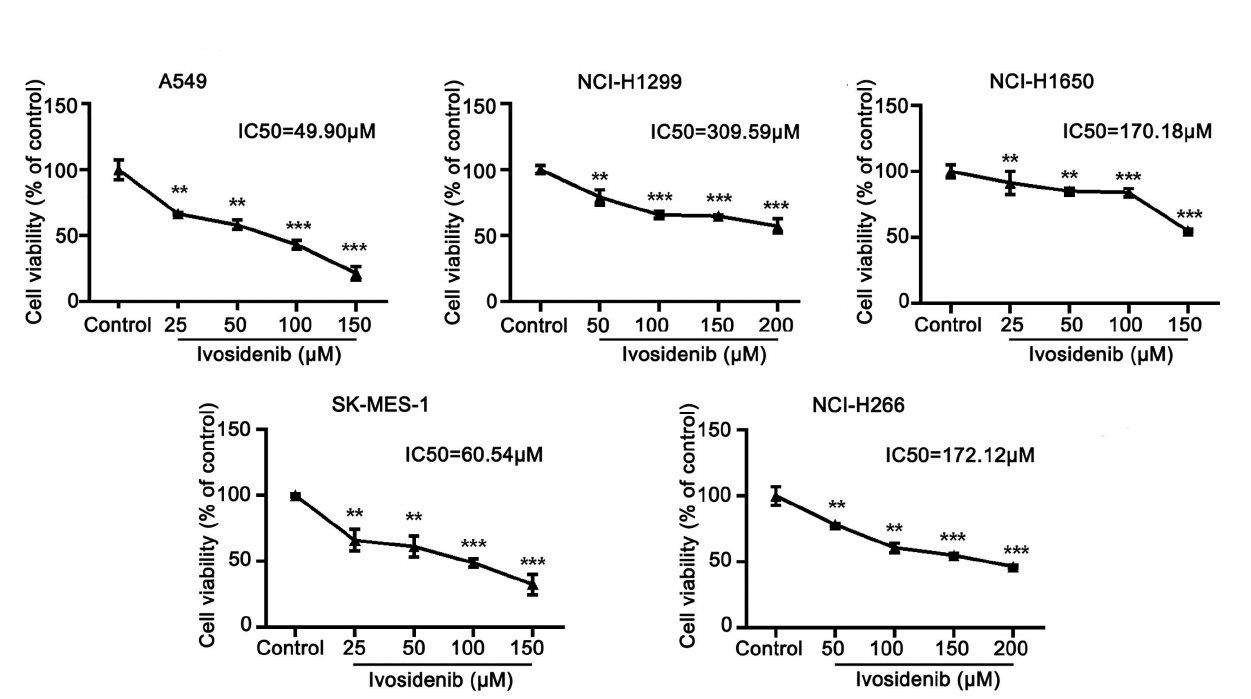
FIGURE 2 | The sensitivity of different NSCLC cell lines to ivosidenib. NSCLC cells were treated with the control (RPMI-1640 culture) and various concentrations of ivosidenib for 24 h, cell proliferation was measured using a MTT assay. The MTT assay was performed to determine cell viability and values are expressed as the mean ± SD of three separate experiments. ** p < 0.01, and *** p < 0.001 vs.